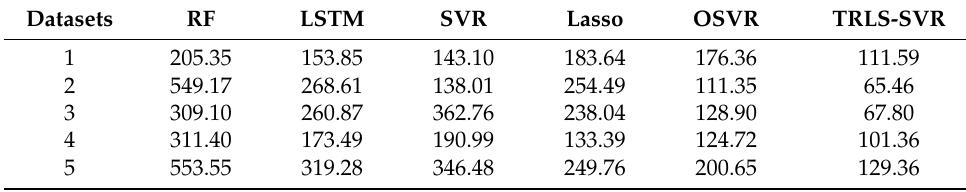
Table 4. RMSE of different methods in five datasets.